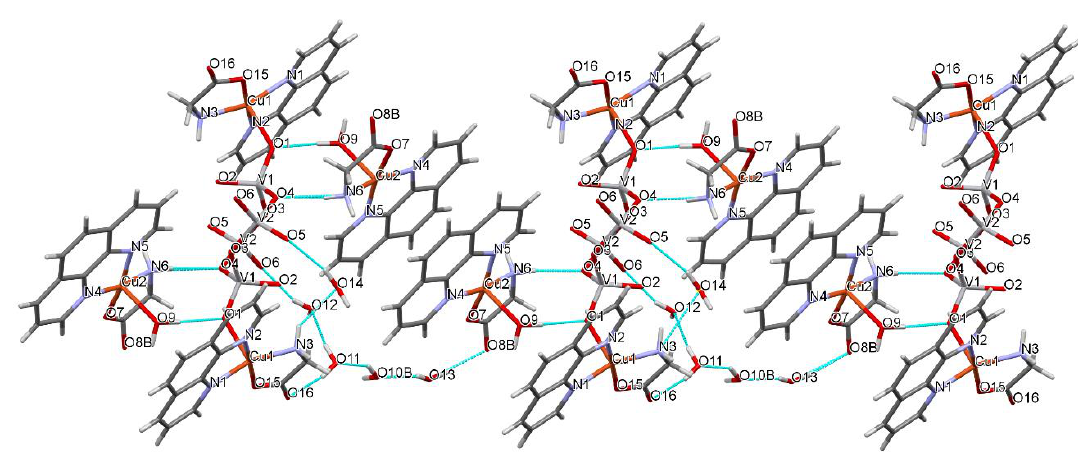
Figure 5. Capped stick representation of the hydrogen bond network communicating the cyclotetravandates in the [1,0,0] direction .